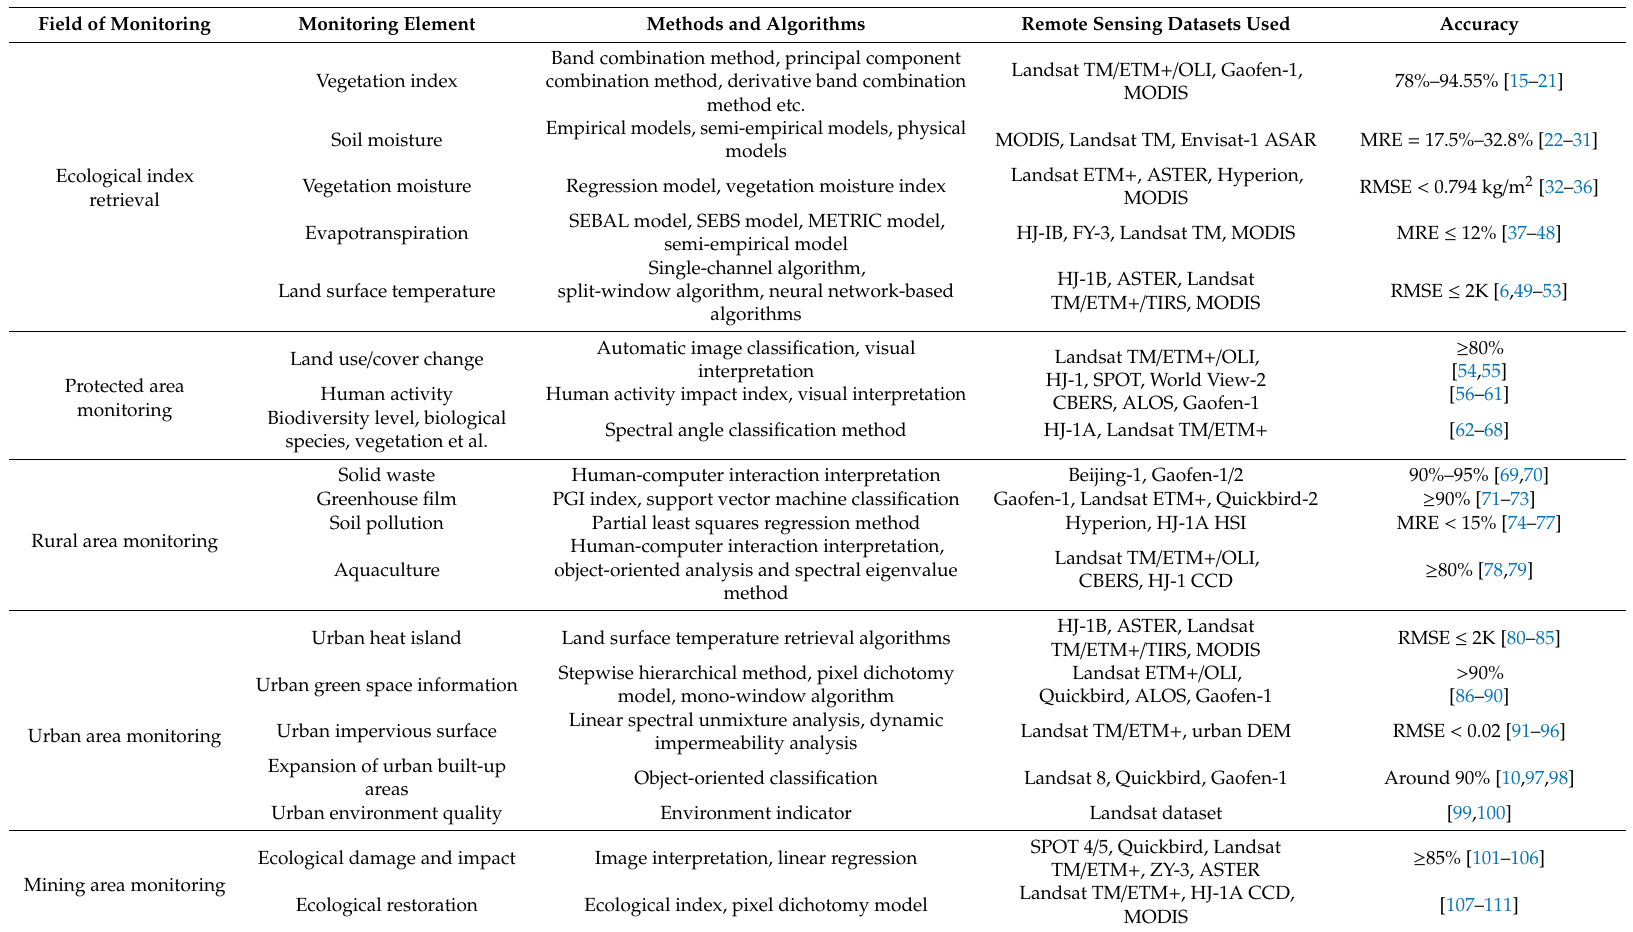
Table 3. Studies of environmental monitoring by remote sensing in